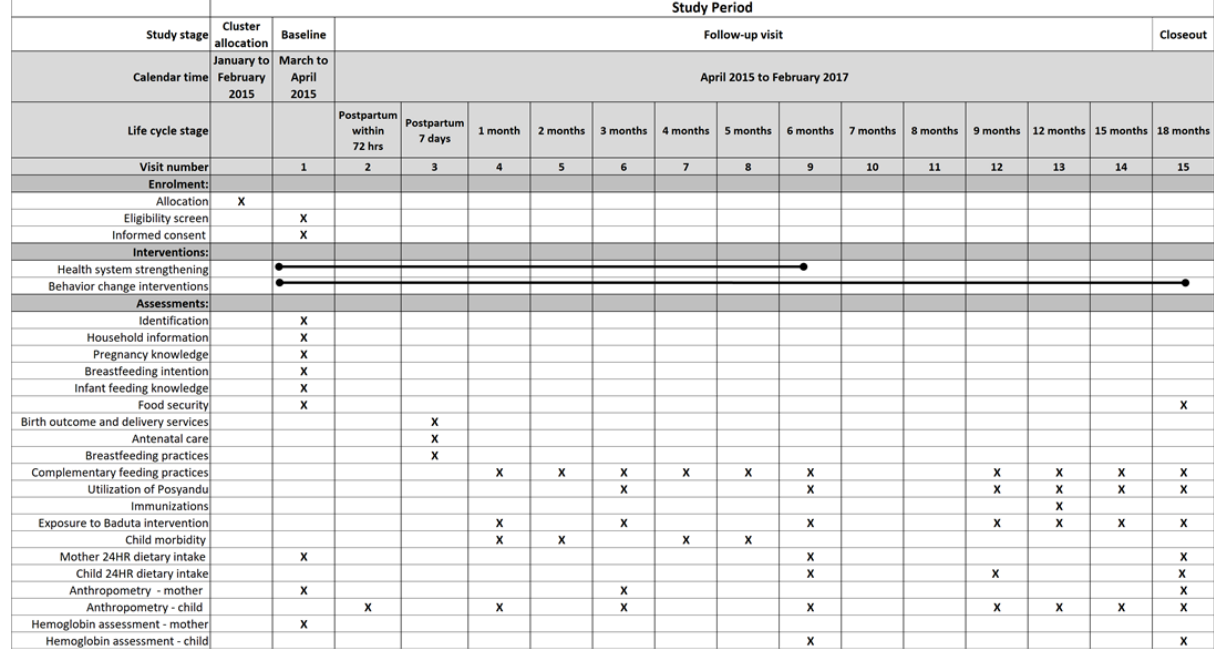
Figure 3. Schedule of enrollment, interventions, and assessments for cohort evaluation. X: indicates activity occurred at given visit or life cycle stage; lines mark the duration of the interventions; 24 HR: 24-hour dietary